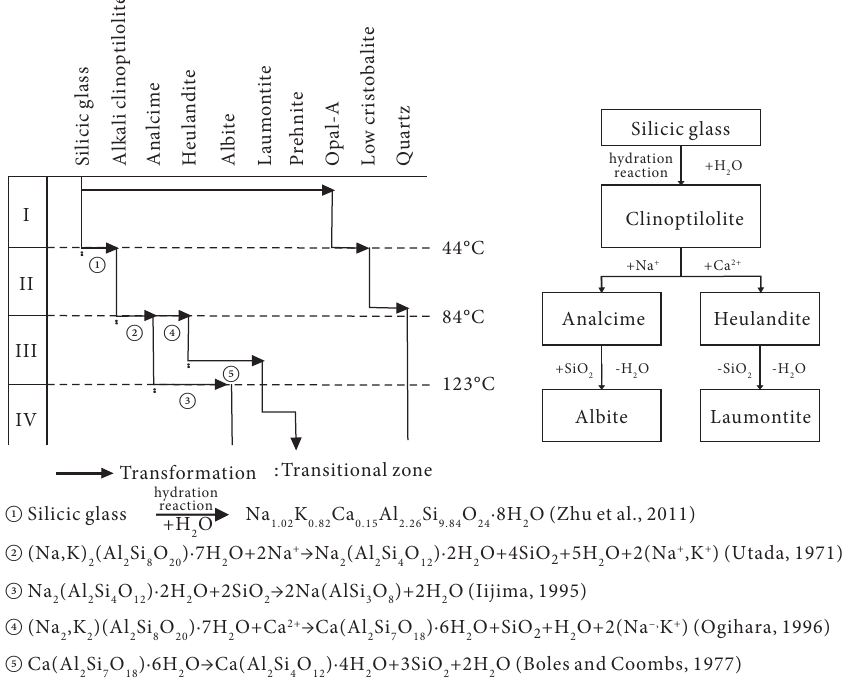
Figure 3: Present-day borehole temperatures at boundaries between zeolite zones in the Japanese islands (modified according to Lijima, 2001) [42].